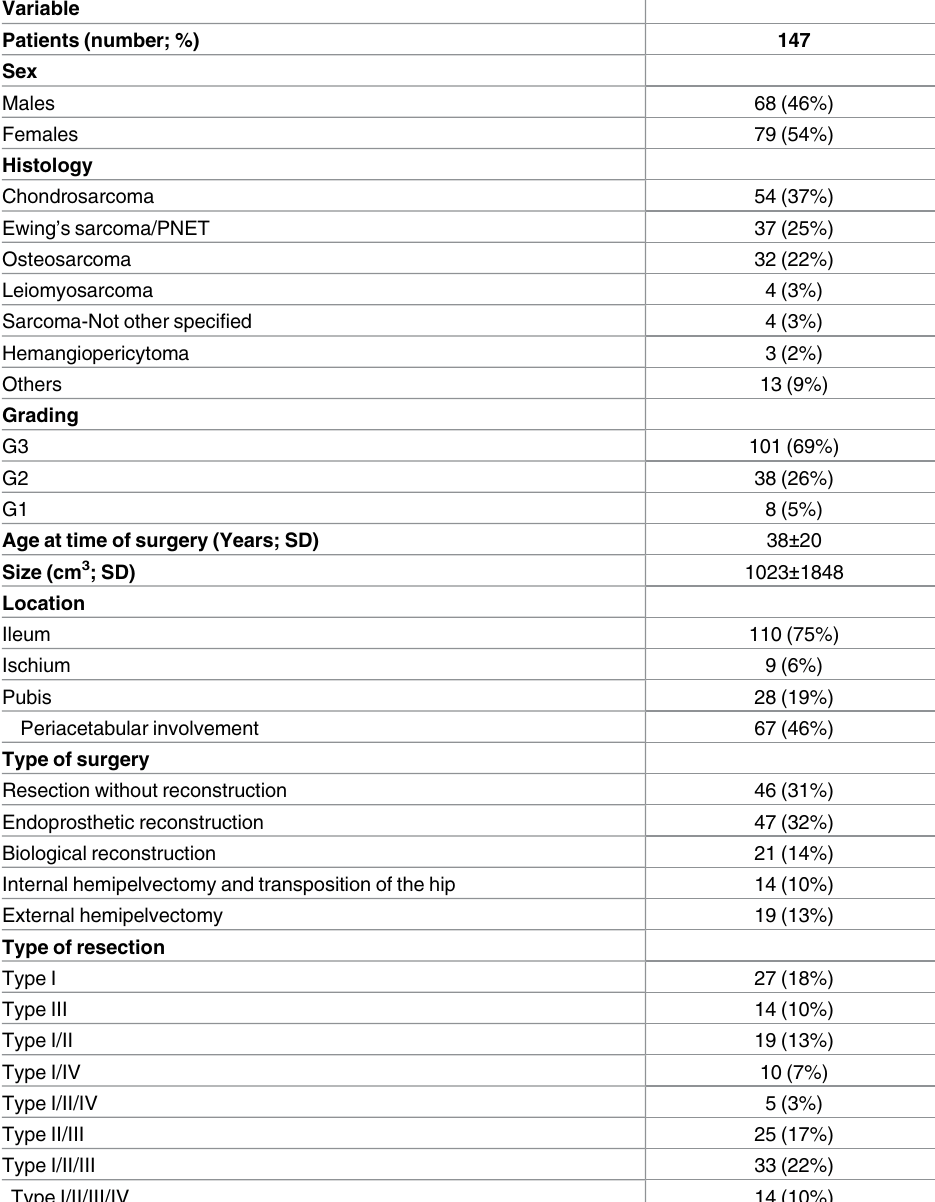
Table 1. Baseline characteristics and operative